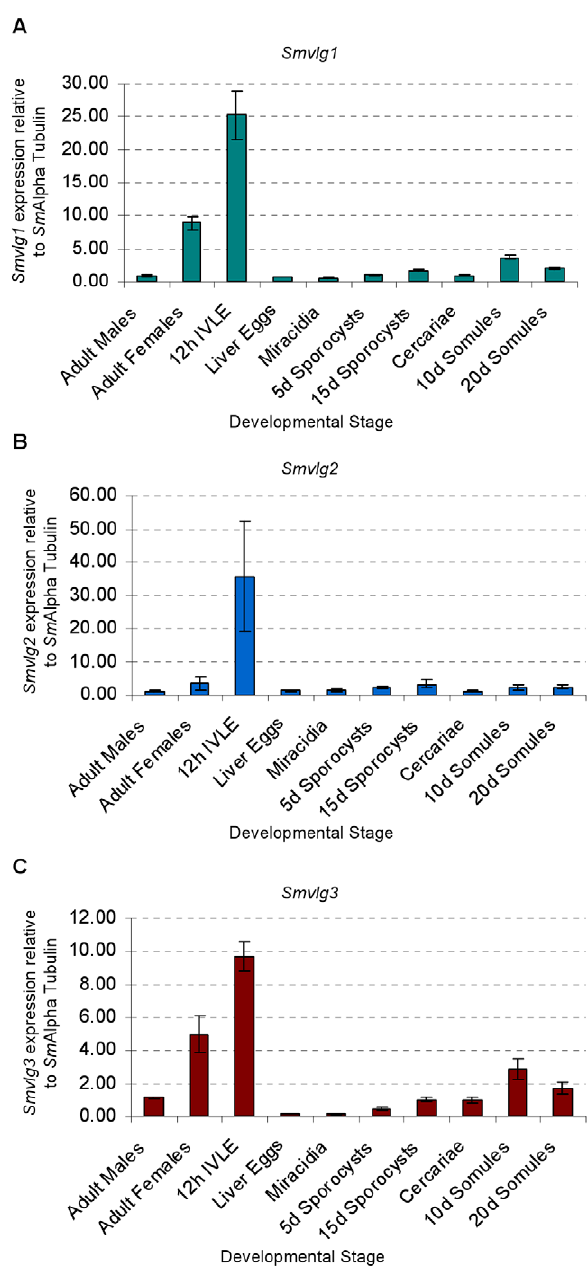
Figure 3. Developmental expression of Vasa-like DEAD-box helicases in Schistosomamansoni . Expression levels of Smvlg1 (Panel A), Smvlg2 (B) and Smvlg3 (C) of developmental stages of S. mansoni were determined by quantitative real time PCR. Normalized fold expression of the vasa -like genes is presented; bars represent one standard deviation of the